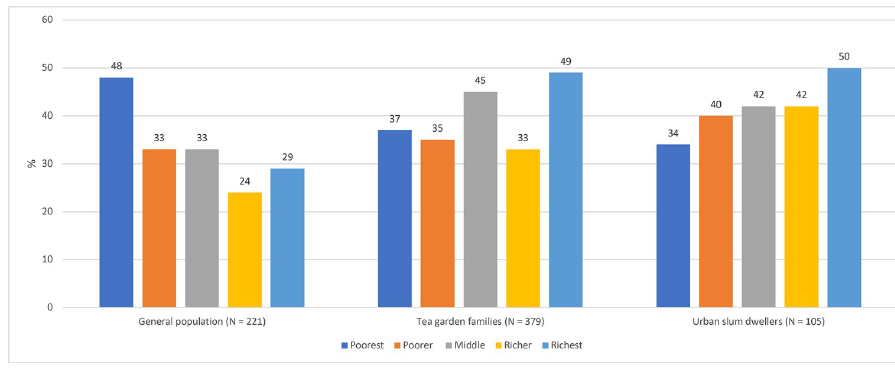
Fig 3. Proportion of patients with catastrophic cost by wealth